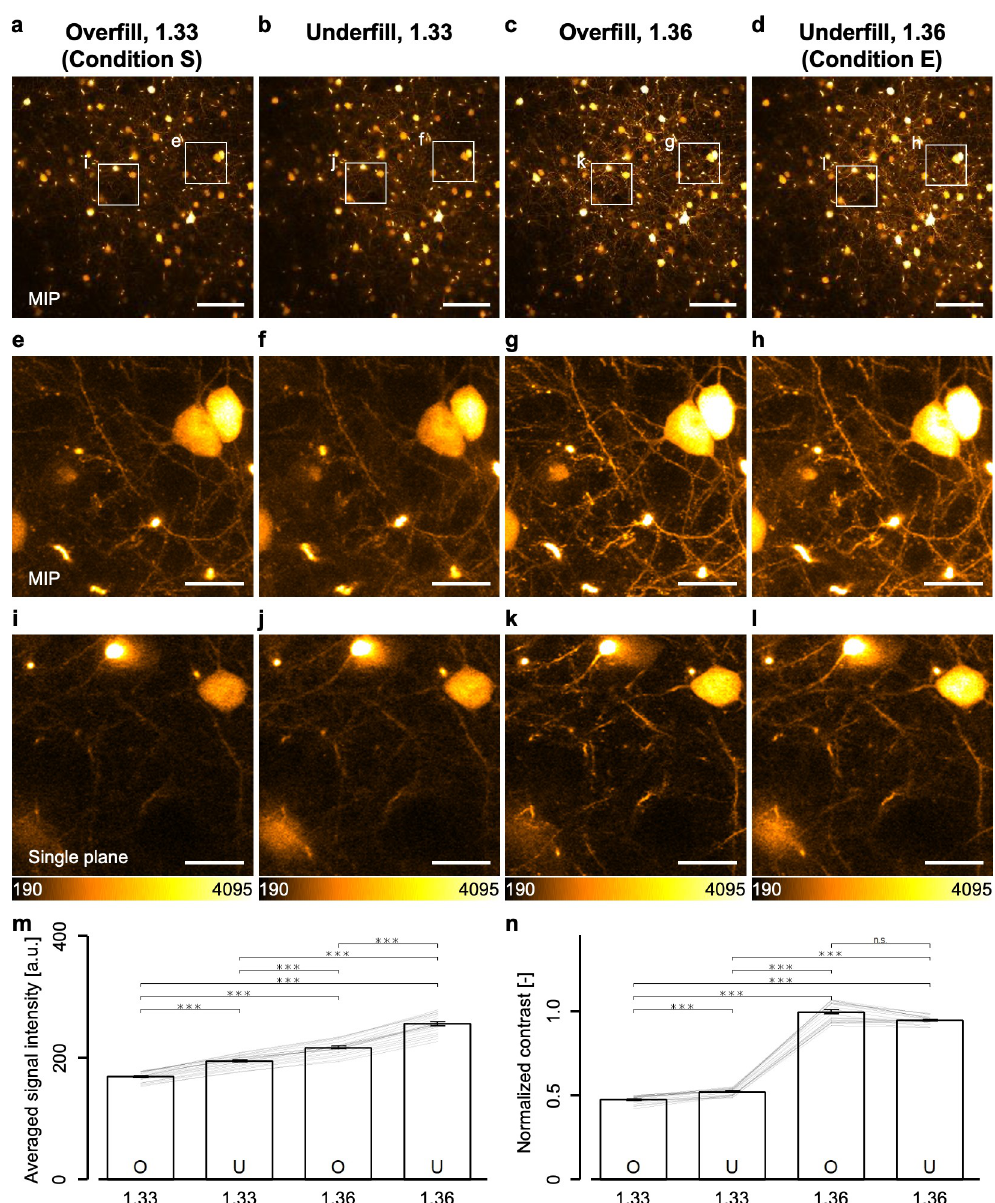
Fig 4. Two-photon imaging of cortical layer V neurons in living mouse brains under all conditions. (a-d) Max intensity projection images with 10 μ m thickness obtained from cortical layer V under each condition. (e-h) Enlarged views in the white rectangle regions in (a – d). (i – l) An enlarged view in the white rectangle regions in (a – d) but not max intensity projections. (m) Averaged fluorescence signal intensities of 21 cross-sectional images under each condition. The lines in the graph show the calculated value of the signal intensities excluding the background intensities ( see Materials and methods ) at each xy -plane (21 cross-sectional images). (n) Contrast values normalized with the value of the combination of the overfill and 1.36 condition. The lines in the graph show the calculated value at each xy -plane (21 cross-sectional images). The scale bars shown in (a – d) and (e – l) represent 100 and 20 μ m, respectively. Error bars represent s.e.m. ��� p < 0.001 (Friedman test with post-hoc DSCF all-pairs comparison